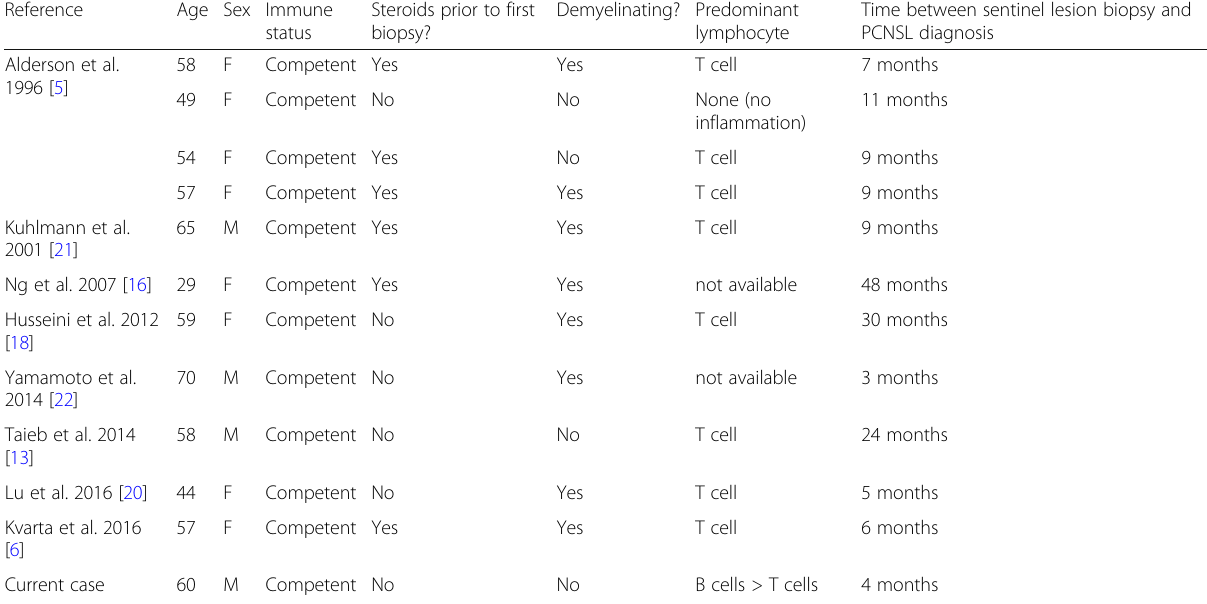
Table 1 Reported PCNSL cases preceded by sentinel